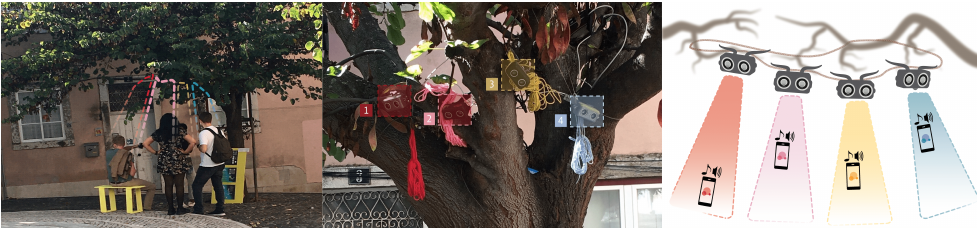
Figure 7. Public installation using four proximity sensors placed inside foliage with hanging ribbon. Sensors are physically separated by sensing trajectories, identified by